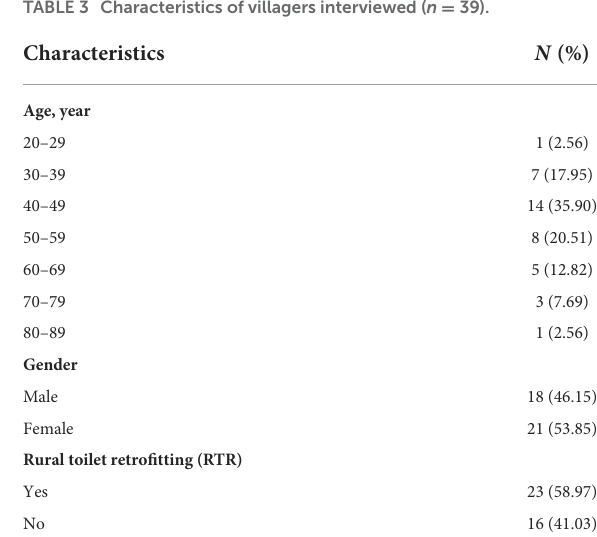
TABLE 2 Characteristics of village cadres interviewed ( n = 7). TABLE 3 Characteristics of villagers interviewed ( n =